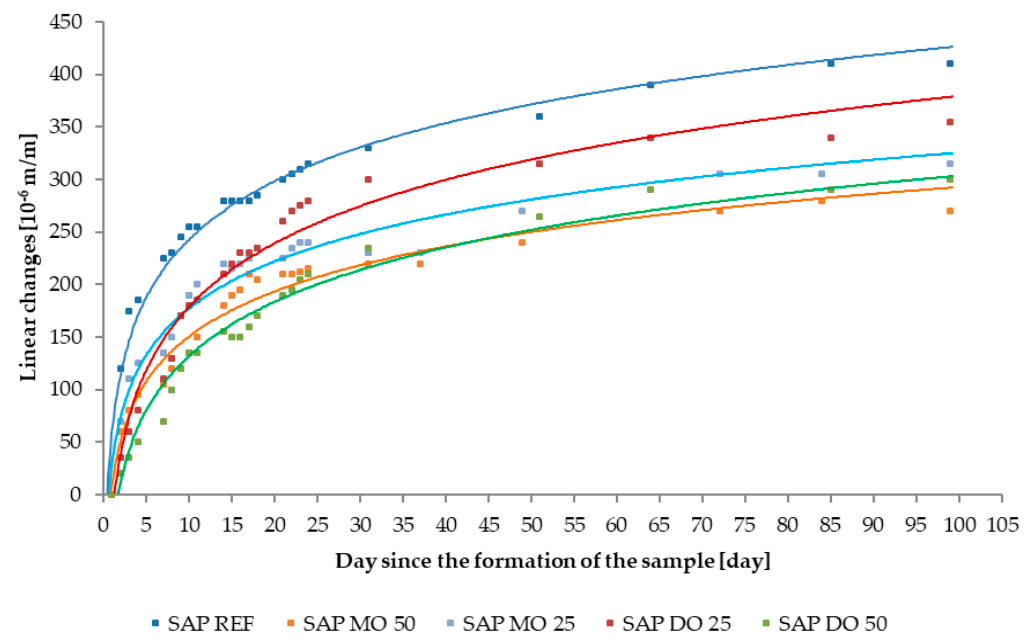
Figure 9. The effect of type of superabsorbent polymers (SAP) (SAP M and SAP D) on the autogenous shrinkage. The linear changes axis presents shrinkage, not expansion.